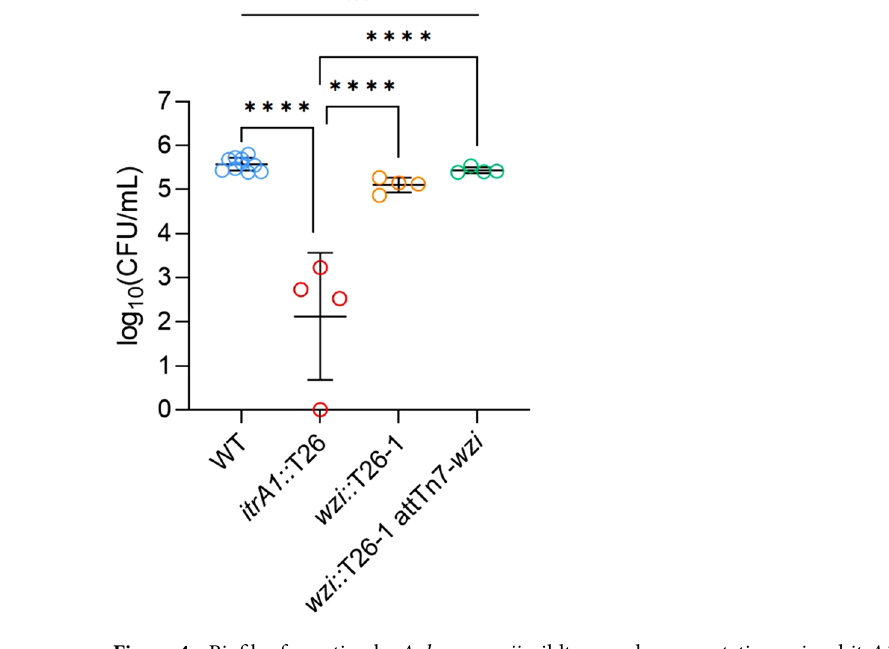
Figure 4. Biofilm formation by A. baumannii wildtype and representative wzi and itrA1 mutants. Cells were recovered from biofilms grown on MBEC pegs for 24 h at 37 °C in LB. Viable CFU mL −1 were enumerated by serial dilution and plating on LB agar. Dot plots show data from at least 2 biological repeats each with 2 technical replicates. Horizontal lines show group means and standard deviation. The data were analysed by an ordinary